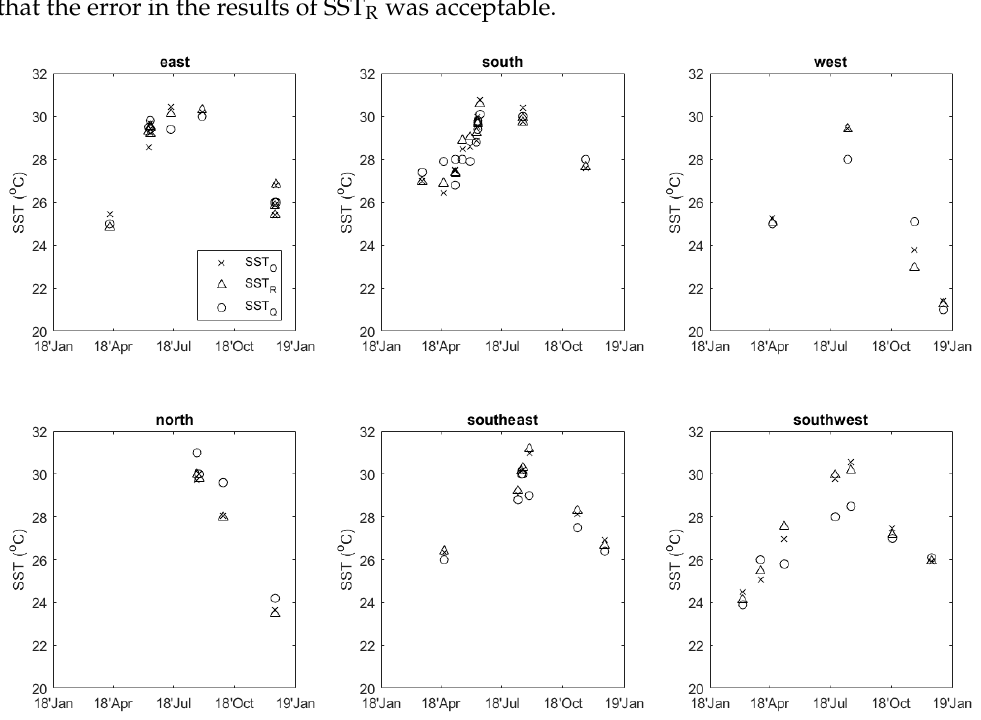
Figure 7. Time series comparison of SST Q with SST O and SST R in the six areas.